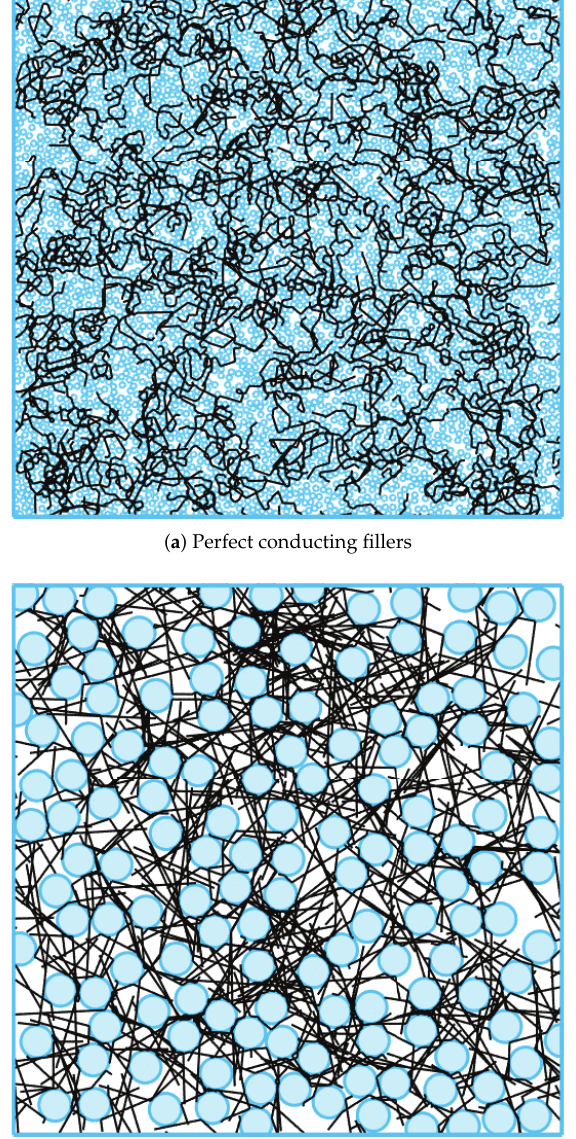
Figure 5. Random percolating configurations of conductance invariance with respect to secondary filler